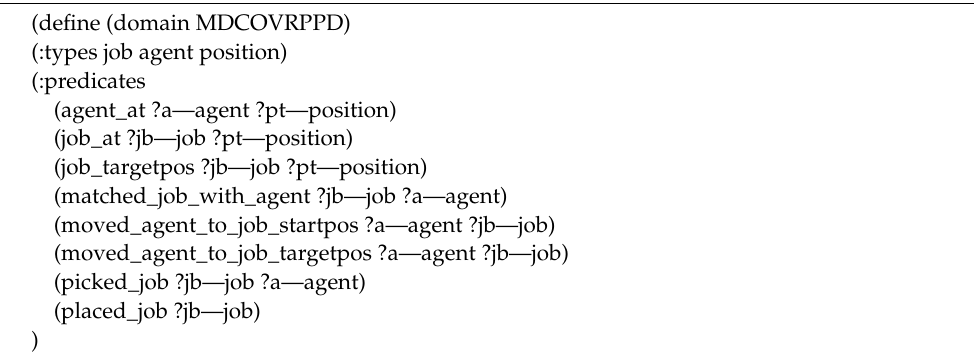
Algorithm 1 Types and predicates definition of MDCOVRPPD planning domain description.